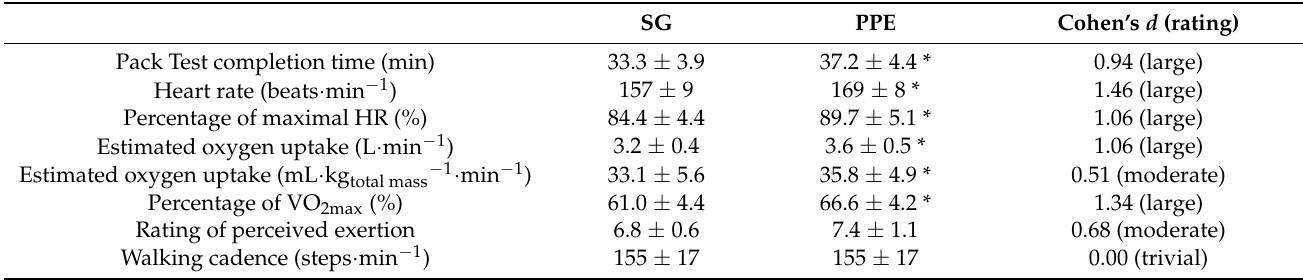
Walking cadence (steps · min − 1